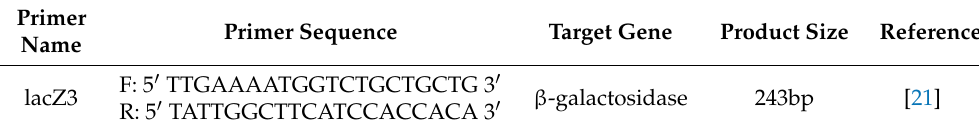
Table 1. The targeted gene, primer sequence and product